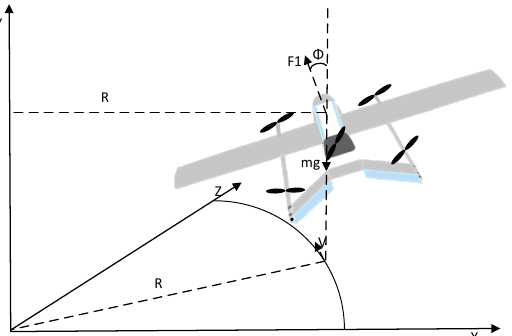
Figure 1. Kinematic parameters and variable description of the UAV.